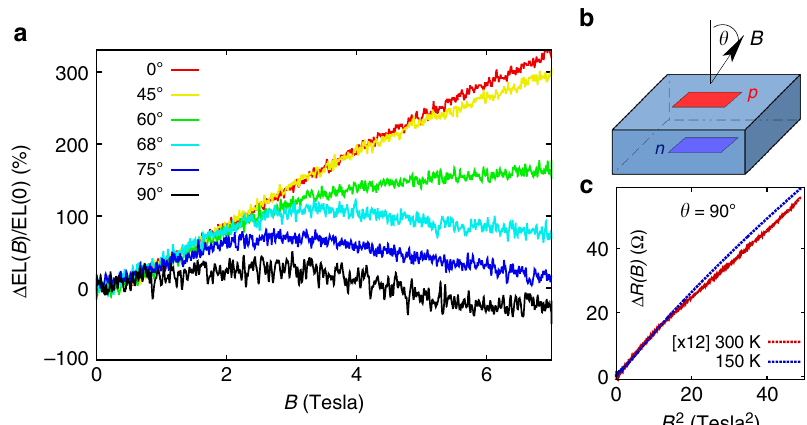
Fig. 4 Angular dependence of magneto-electroluminescence in silicon light-emitting devices. Evolution of the magneto-electroluminescence as a function of the tilt angle θ between the magnetic fi eld and the 5 mA DC current at 150 K (data shown in a , experiment geometry is sketched in b ). c MR response measured at θ = 90°, which displays the classical B 2 dependence that contrasts with the MEL fi eld